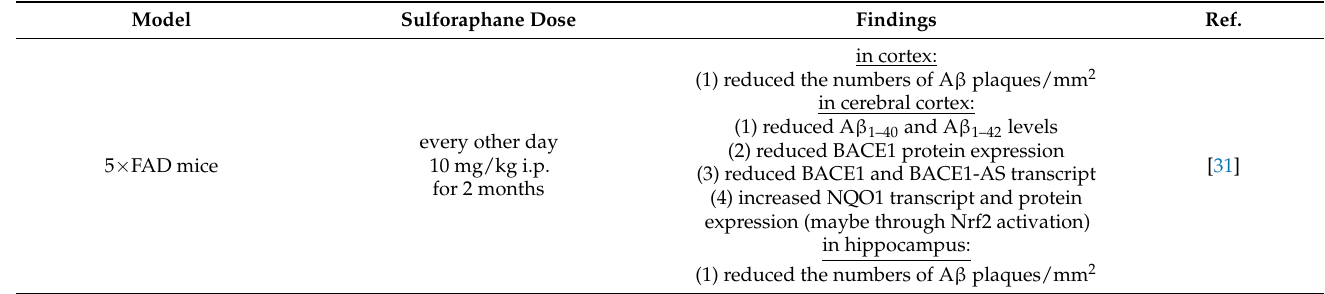
Table 2. The effects of sulforaphane on A β and tau in Alzheimer’s disease (AD)-like models.